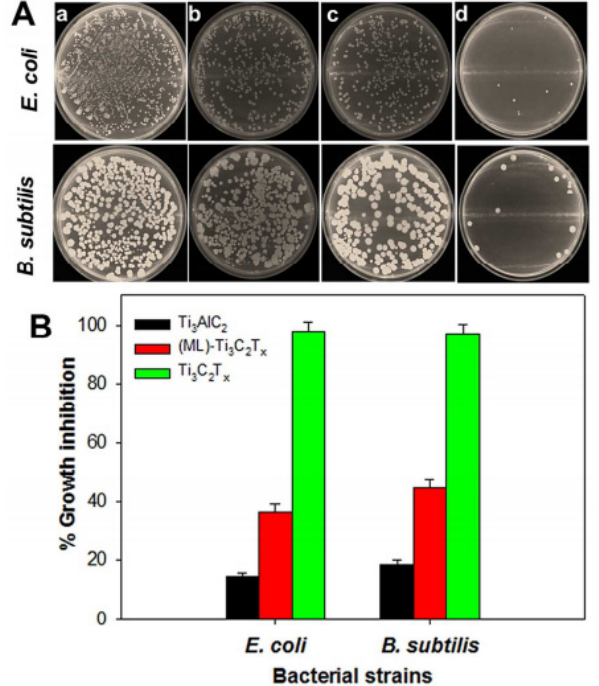
Figure 12. ( A ) Photographs of agar plates onto which E. coli ( top panel ) and B. subtilis ( bottom panel ) bacterial cells were re-cultivated after treatment for 4 h with a control ( a ), and 100 µ g/mL of Ti 3 AlC 2 ( b ), ML-Ti 3 C 2 T x ( c ) and delaminated Ti 3 C 2 T x ( d ). ( B ) Percentage of growth inhibition of bacterial cells treated with 100 µ g/mL of Ti 3 AlC 2 , ML-Ti 3 C 2 T x and delaminated Ti 3 C 2 T x [3].